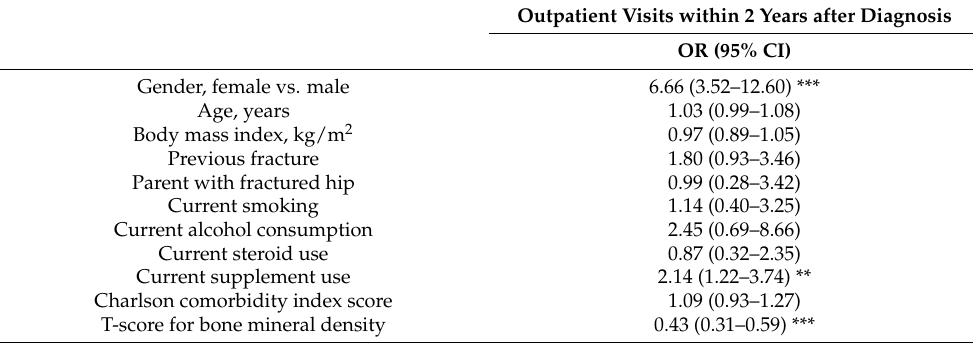
Table 2. Multivariable Cox proportional regression of the associated factors for outpatient